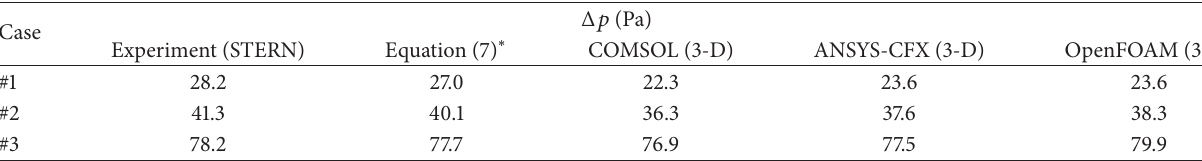
Table 4: Comparison of pressure drop for the STERN laboratory experiment, 3D.